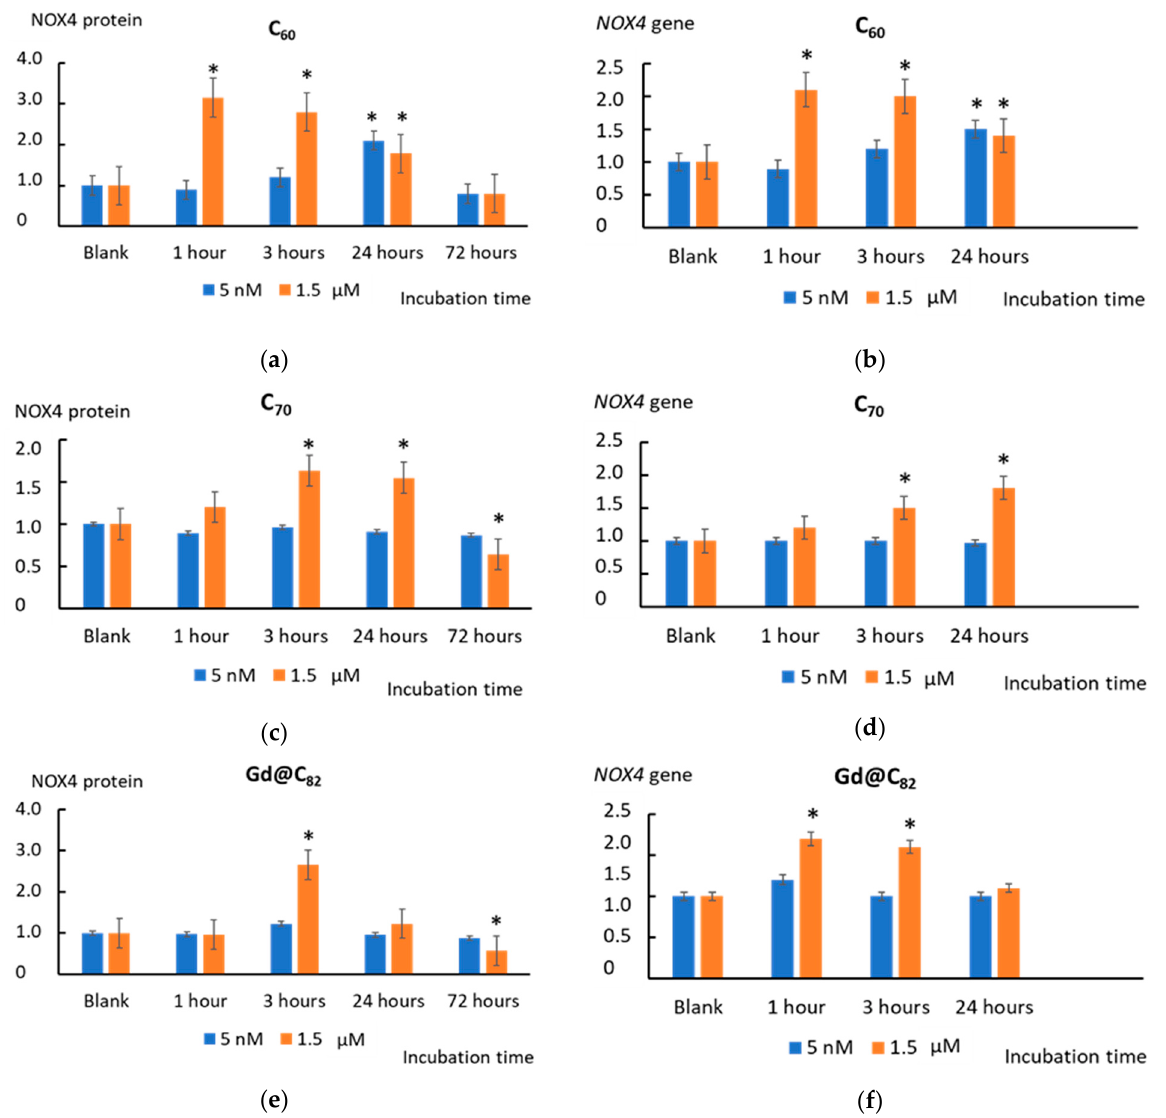
Figure 8. The NOX4 protein level in cells treated with ( a ) C 60 , ( c ) C 70 , and ( e ) Gd@C 82 at the concentrations of 5 nM and 1.5 µM. The expression of the NOX4 gene in cells incubated with ( b ) C 60 , ( d ) C 70 , and ( f ) Gd@C 82 at the concentration of 5 nM and 1.5 µM. The NOX4 RNA level is the mean from three replicates related to the NOX4 gene expression in the blank cells. The TBP gene was used as an internal-standard gene. The blank cells were incubated without the AFDs. (*) denotes significant differences with the blank cells, p < 0.01, a nonparametric U-test.